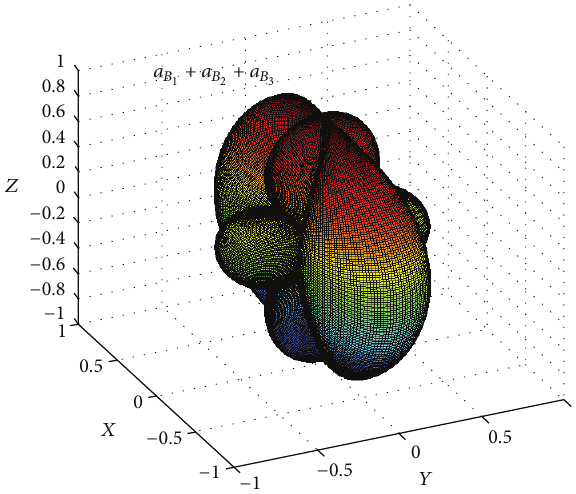
Figure 8: Radiation patterns of the triple-polarized half-wavelength dipole in 3D form.